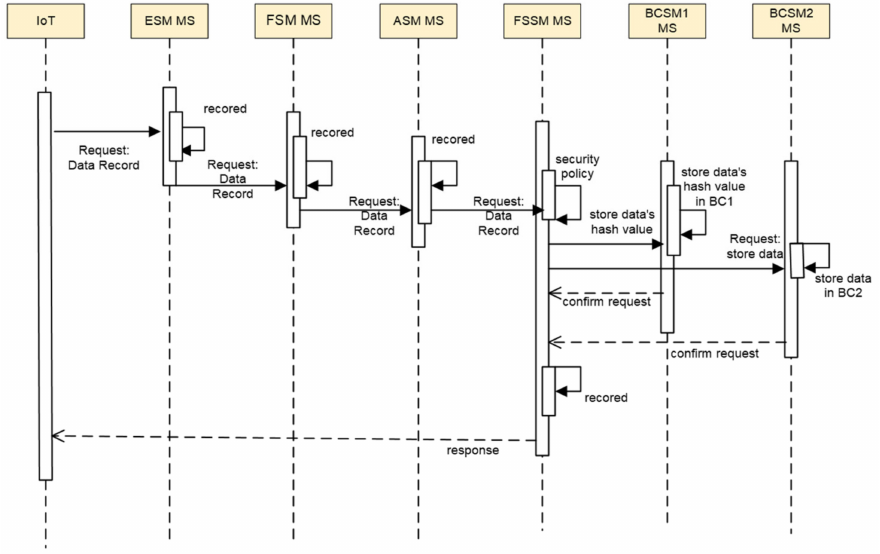
Figure 5. Sequential diagram of the execution of our